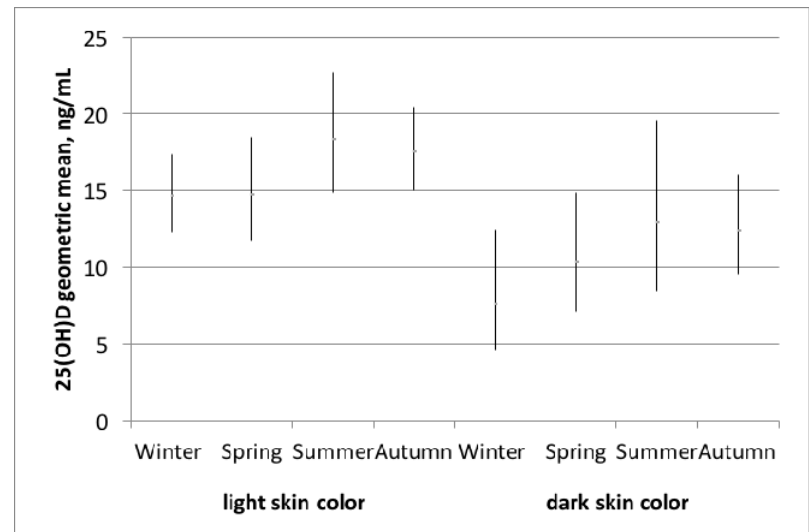
Nutrients 2017 , 9 , 260 6 of 10 Figure 1. Vitamin D levels stratified by light and dark skin color and season according to the